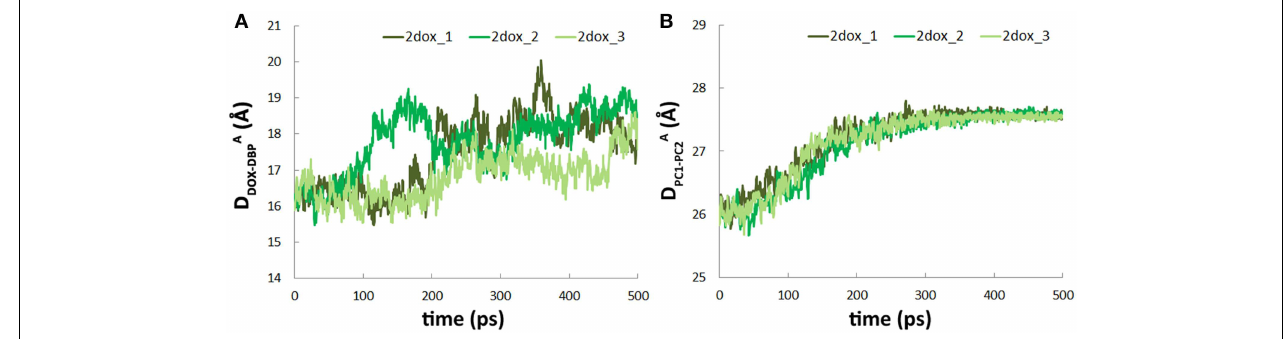
( Figure 1E ), and the opening of the exit gate ( Figure 1F ).